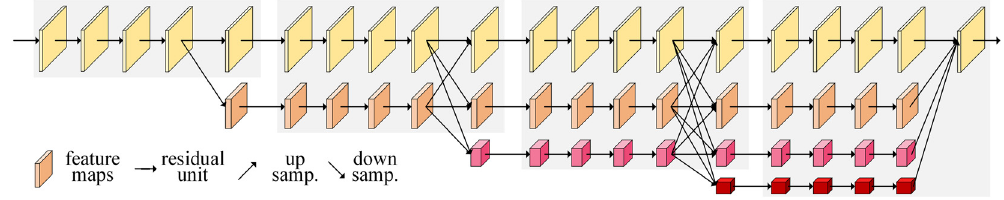
Figure 1: The structure of